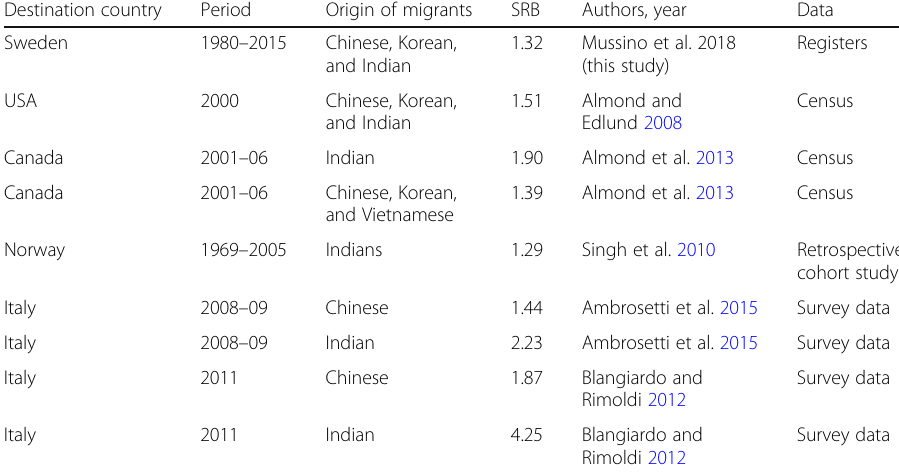
Table 5 Current studies on sex ratio at birth, 3rd births with two girls for previous children of immigrant women from China, Korea, and India in different destinations Destination